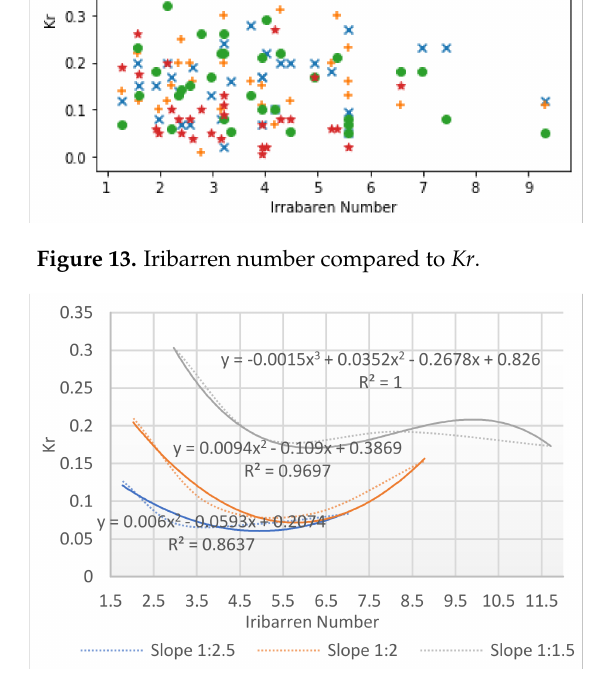
Figure 14. Effect of Iribarren number on reflection